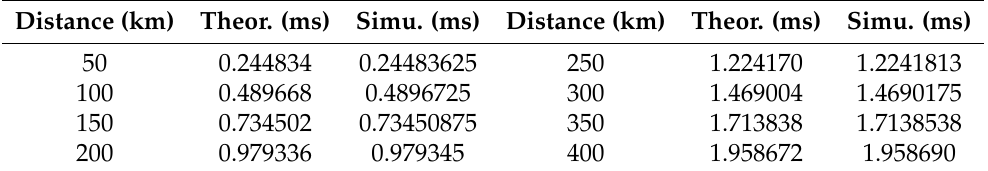
Table 10. Propagation delays based on fiber cable length.